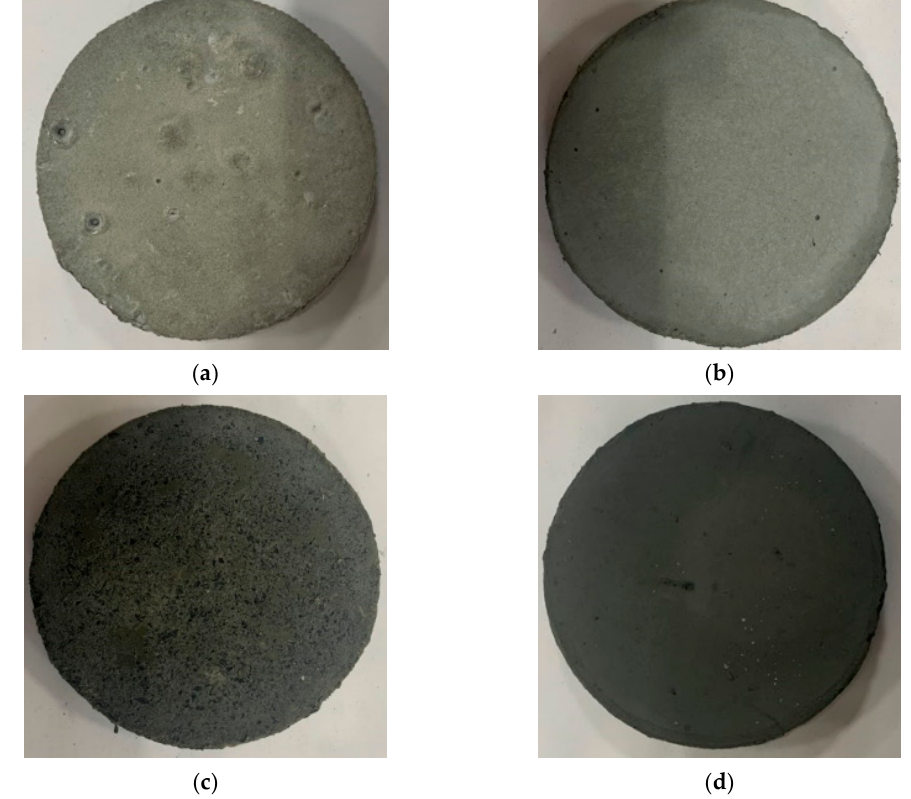
Figure 10. Specimens for Raman spectroscopy. ( a ) Plain; ( b ) MW-P1.0; ( c ) MW-P2.0; and ( d ) MW-L.